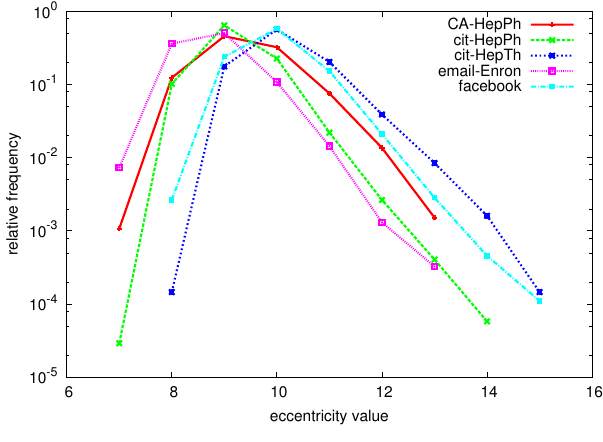
Figure 1. Relative eccentricity distributions of various large